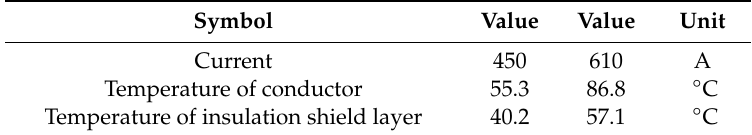
Table 1. The relationship between the current, the temperature of the conductor, and the temperature of the insulation shield